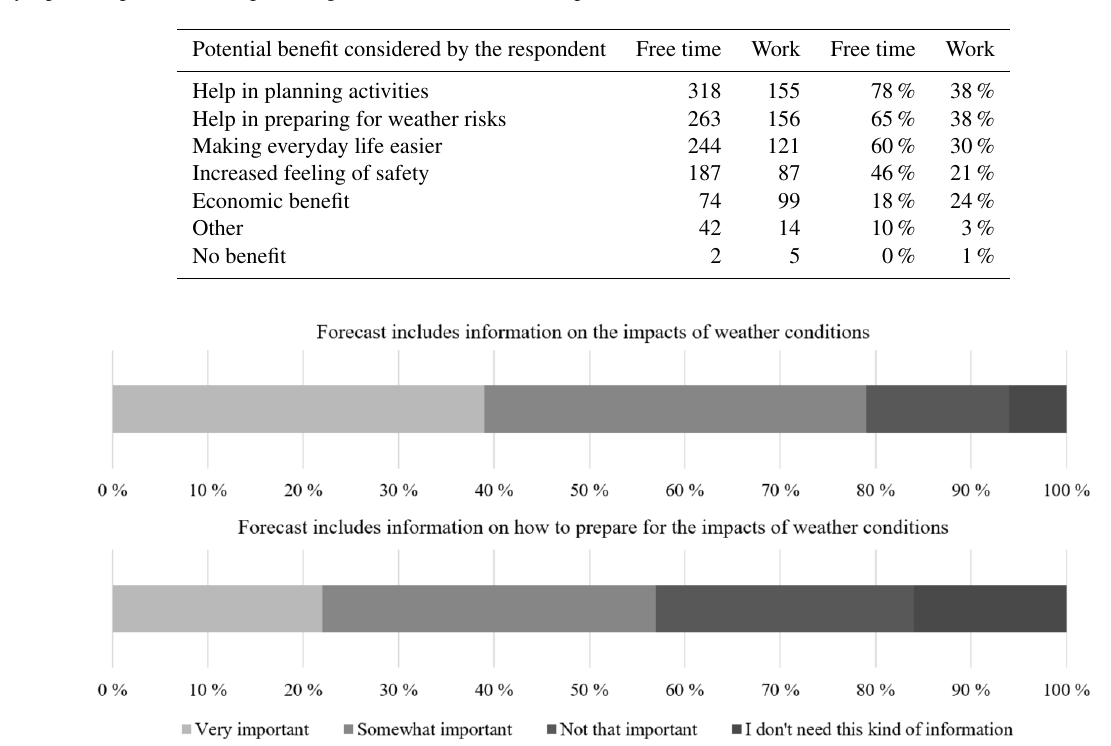
Table 4. Potential benefits considered by the respondents ( N = 406) if using the tailored extended range forecast products presented in the survey’s product portfolio. The percentages indicate the share of respondents that chose the benefit.